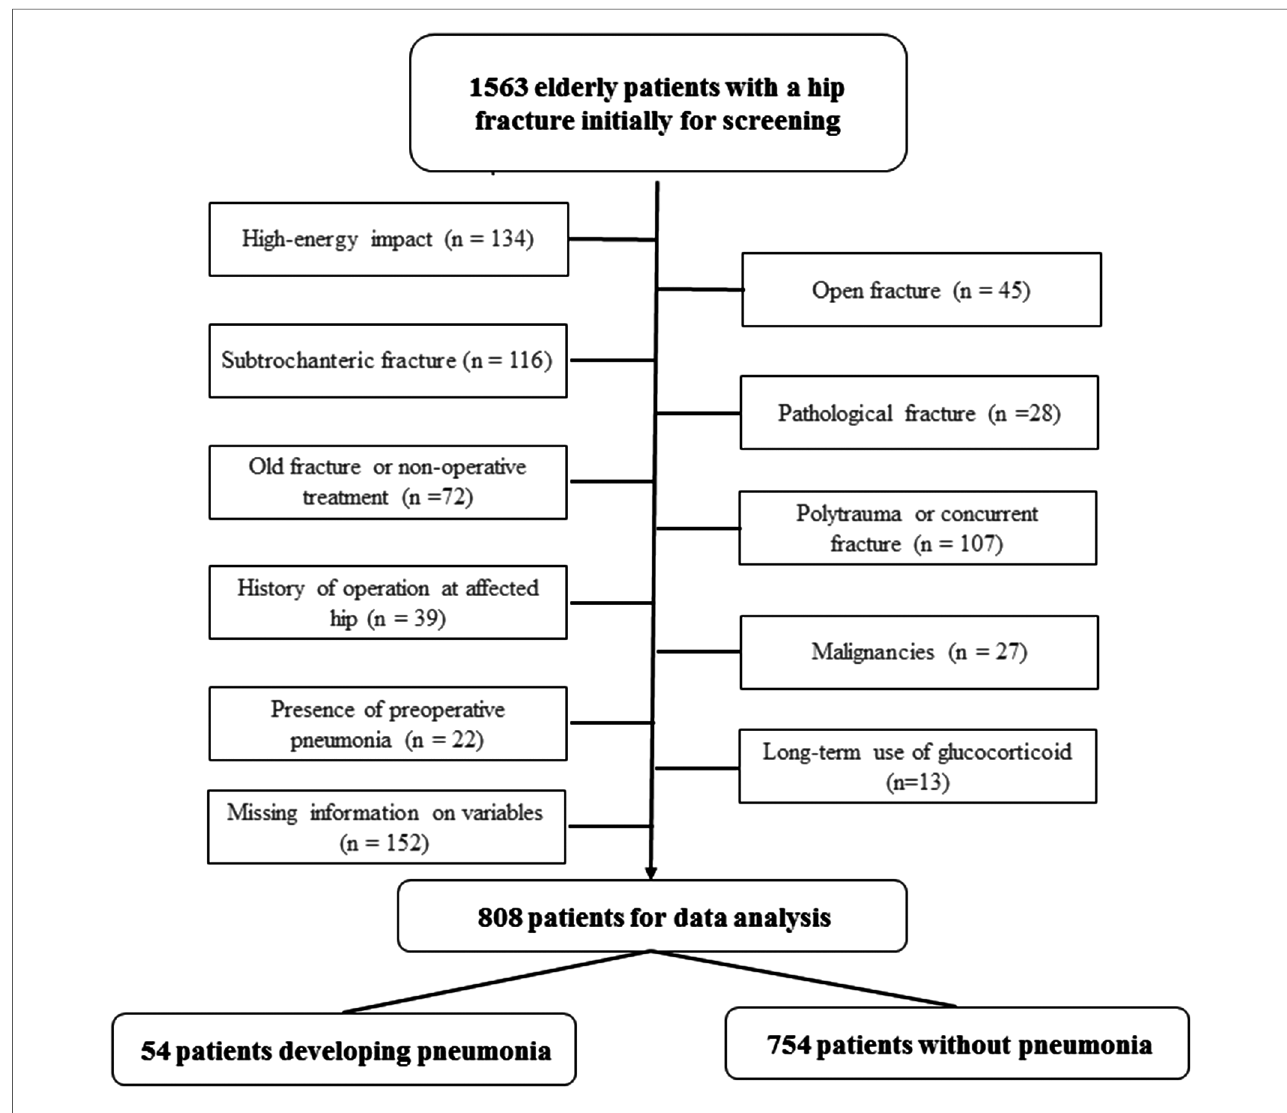
FIGURE 1 The fl owchart showing the screening of eligible